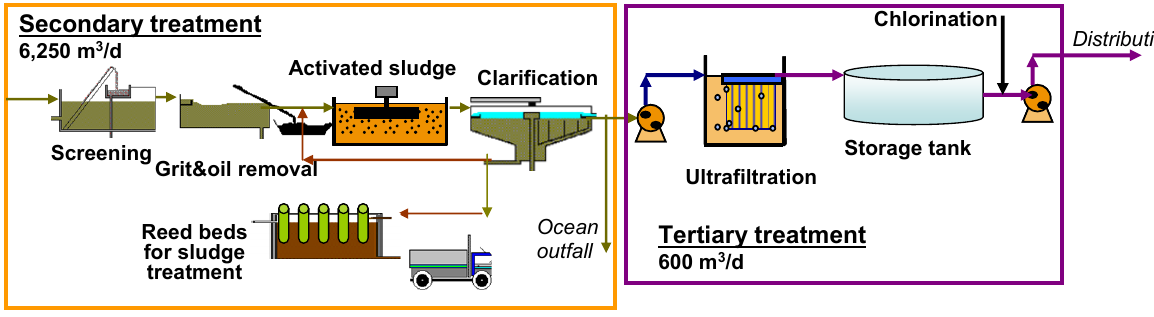
Figure 3. Schematic flow diagram of wastewater treatment and recycling of the Povai wastewater treatment and recycling